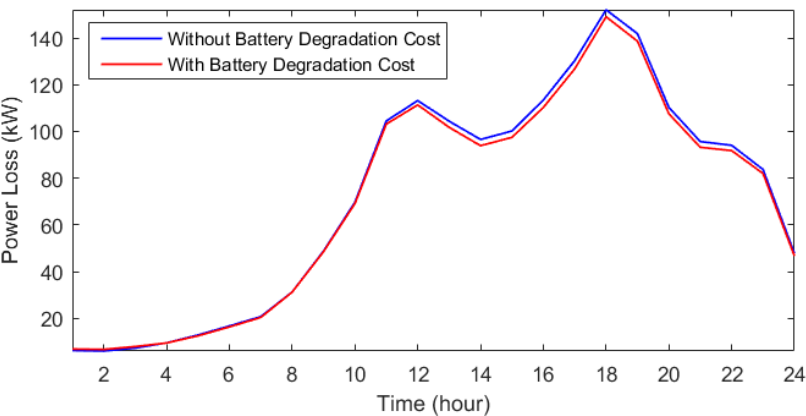
Figure 13. Power loss of the 33-bus distribution network without and with battery degradation cost using the IGJO.